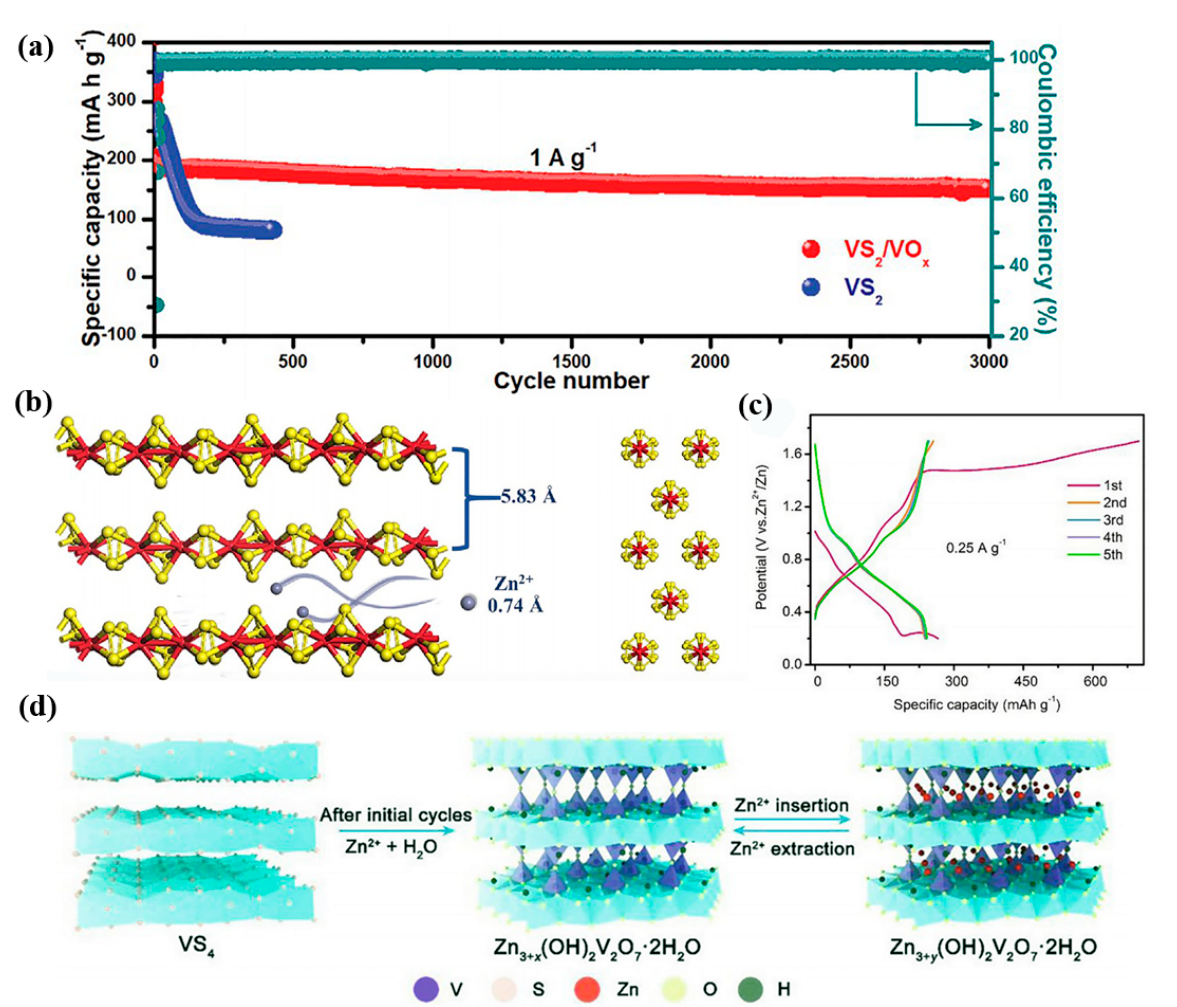
Figure 3. The energy storage mechanism and cycling performance. ( a ) The comparison of cycling performance at 1 A g − 1 . Reproduced with permission [36]. Copyright 2020 Wiley-VCH GmbH. ( b ) The crystal structure of VS 4 materials. Reproduced with permission [37]. Copyright 2020, The Royal Society of Chemistry. ( c ) The charge–discharge curves at 0.25 A g − 1 . ( d ) Schematic of the energy storage mechanism of Zn–VS 4 /CNTs batteries. Reproduced with permission [41]. Copyright 2021, Elsevier B.V. and Science Press.